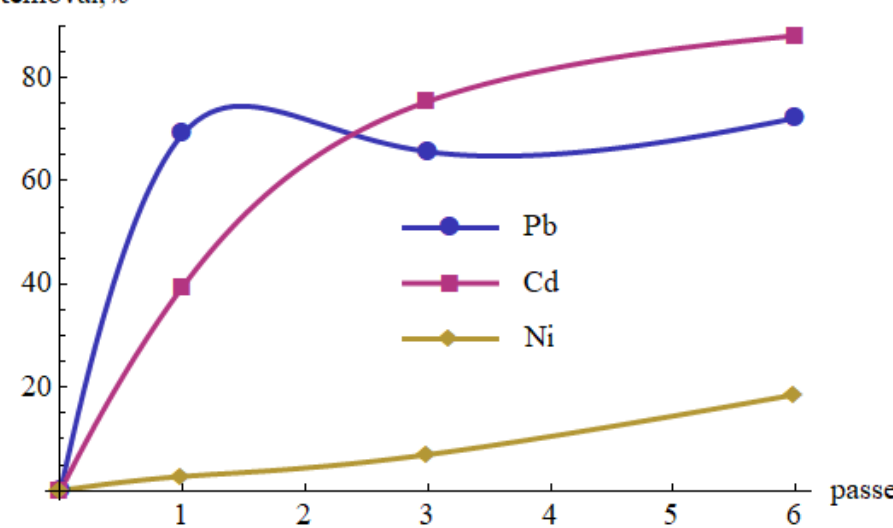
Figure 5. Percentage removal of Pb(II), Cd(II) and Ni(II) from the aqueous solutions vs. number of passes through the cold plasma reactor.